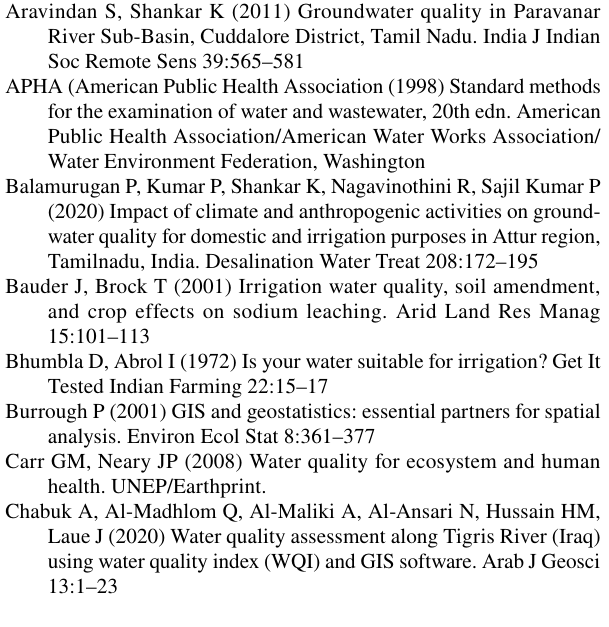
Fig. 6 Cluster analysis of physiochemical parameters for water sam- ples collected from the Sutlej river during pre- and post-monsoon seasons of the years 2017 and